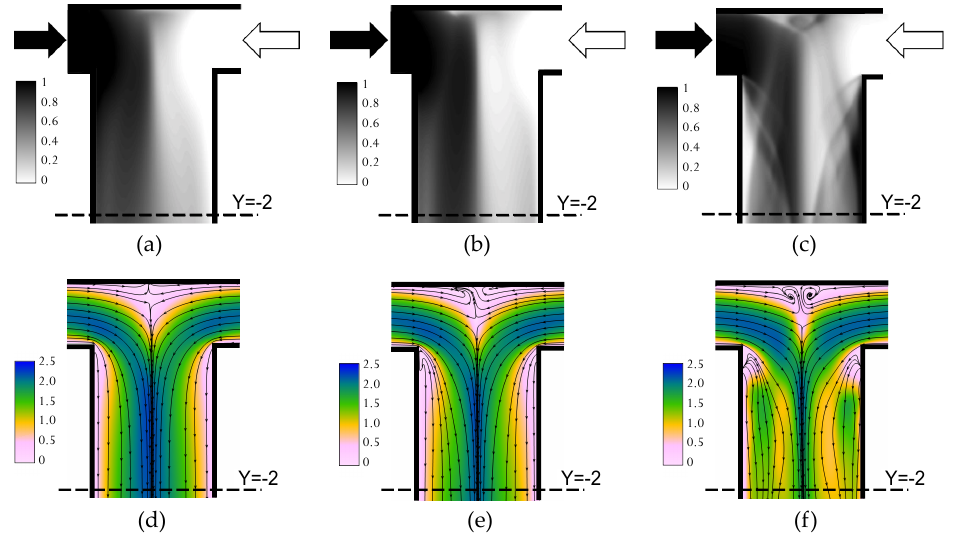
Figure 2. Depth-averaged MB + concentration from numerical simulations in: ( a ) the segregated regime, ( b ) the vortex regime, and ( c ) the engulfment regime. Non-dimensional velocity magnitude and flow streamlines in the horizontal mid-plane in: ( d ) the segregated regime, ( e ) the vortex regime, and ( f ) the engulfment